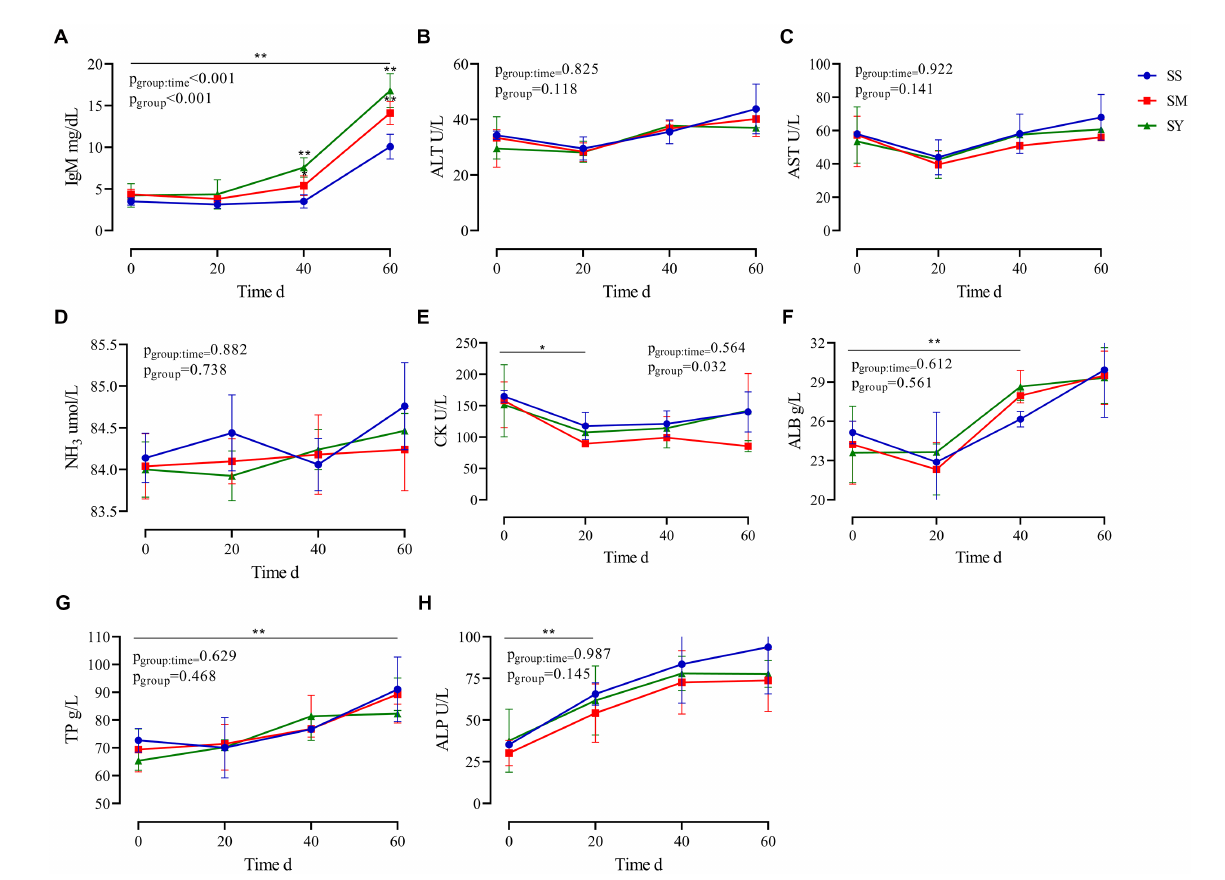
FIGURE 3 Effects of different Se sources on the plasma biochemical indices of beef cattle ( n = 5) over the 60 d feeding period. (A) immunoglobulin M (IgM); (B) alanine aminotransferase (ALT); (C) aspartate transaminase (AST); (D) ammonia (NH 3 ); (E) creatine kinase (CK); (F) albumin (ALB); (G) total protein (TP) and (H) alkaline phosphatase (ALP). * p < 0.05, ** p < 0.01. SS, diet supplemented 0.1 mg Se/kg DM from sodium selenite; SM, diet supplemented 0.1 mg Se/kg DM from selenomethionine; SY, diet supplemented 0.1 mg Se/kg DM from Se-enriched